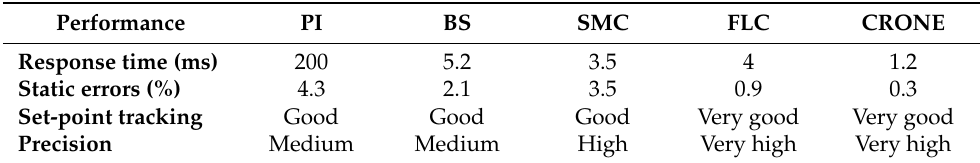
Figure 15. Speed error for PI, BS, SMC, FLC, and CRONE controllers. Table 3. Comparative study of the five MPPT controllers for a step wind